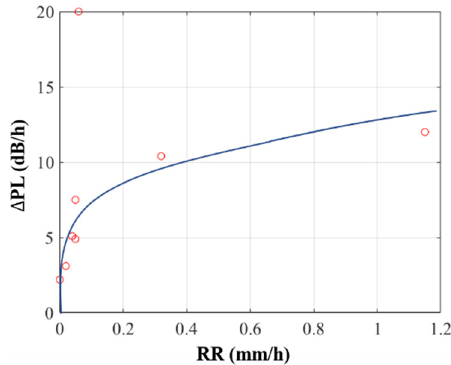
Figure 22. The fitting curve (blue) of ∆ PL and RR, the red circles represent the real values of ∆ PL and RR.